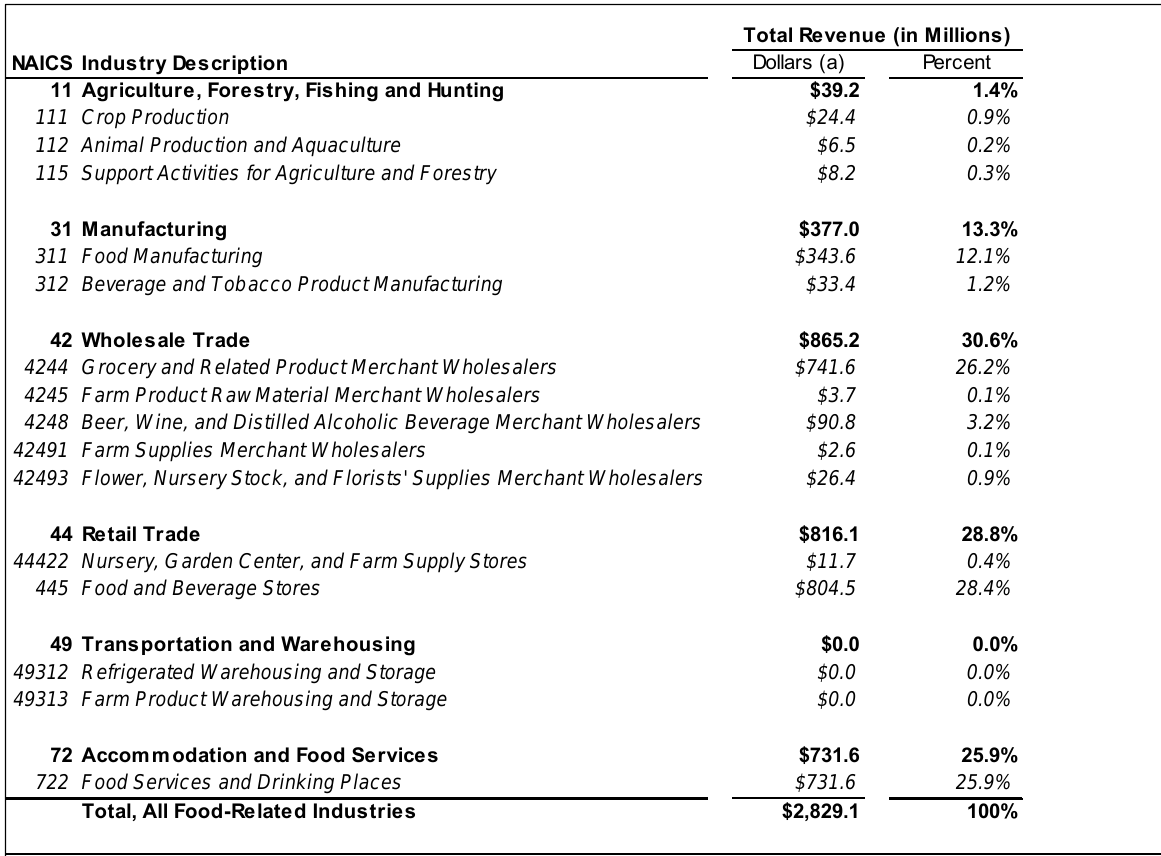
Table 1. Total Revenue of Food-Related Establishments by Industry Sector, City of San Jose